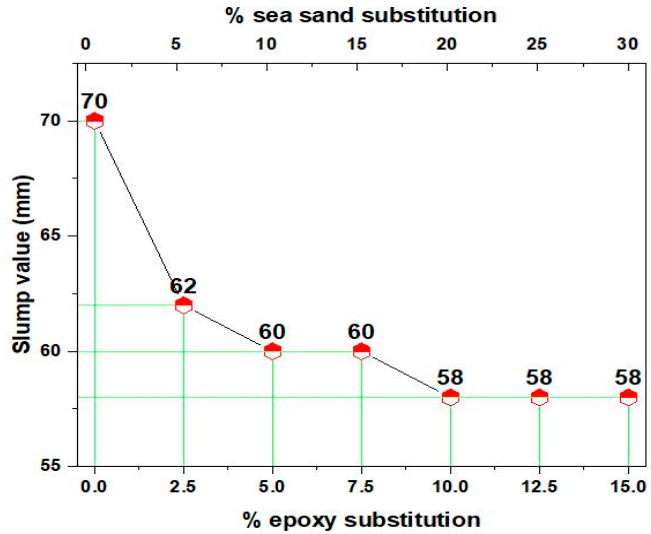
Figure 2. Slump values of various concrete mixes.